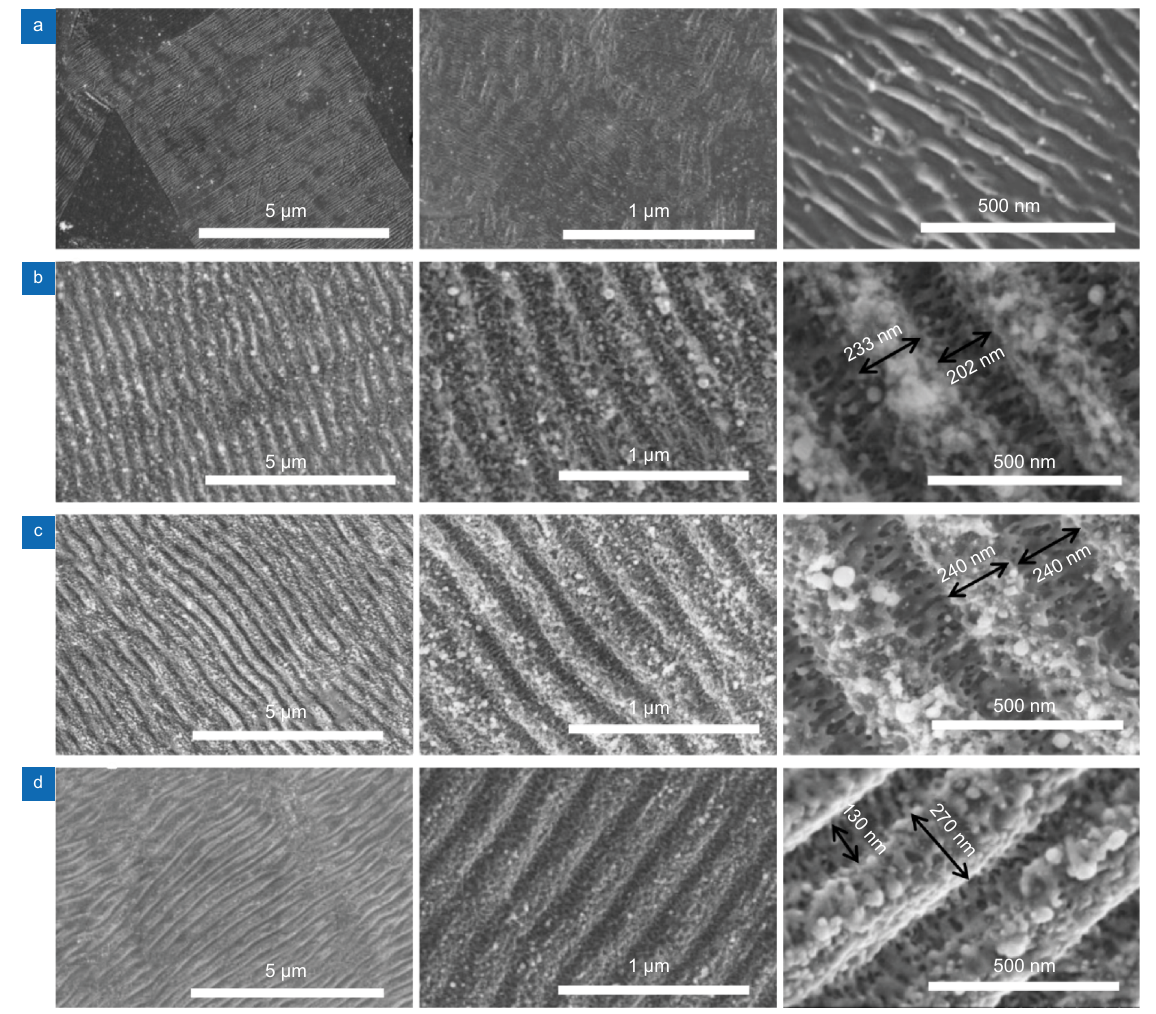
Fig. 3 | The surface morphology and topography of LIPSS patterned electrodes . The SEM images of LIPSS patterned Ni foam (LPNF) elec- trode using ( a ) 236, ( b ) 460, ( c ) 600, and ( d )700 μJ/pulse of femtosecond laser pulse energy having 1 kHz repetition rate. The focused laser beam was scanned on the Ni foam target with the scanning speed of 1